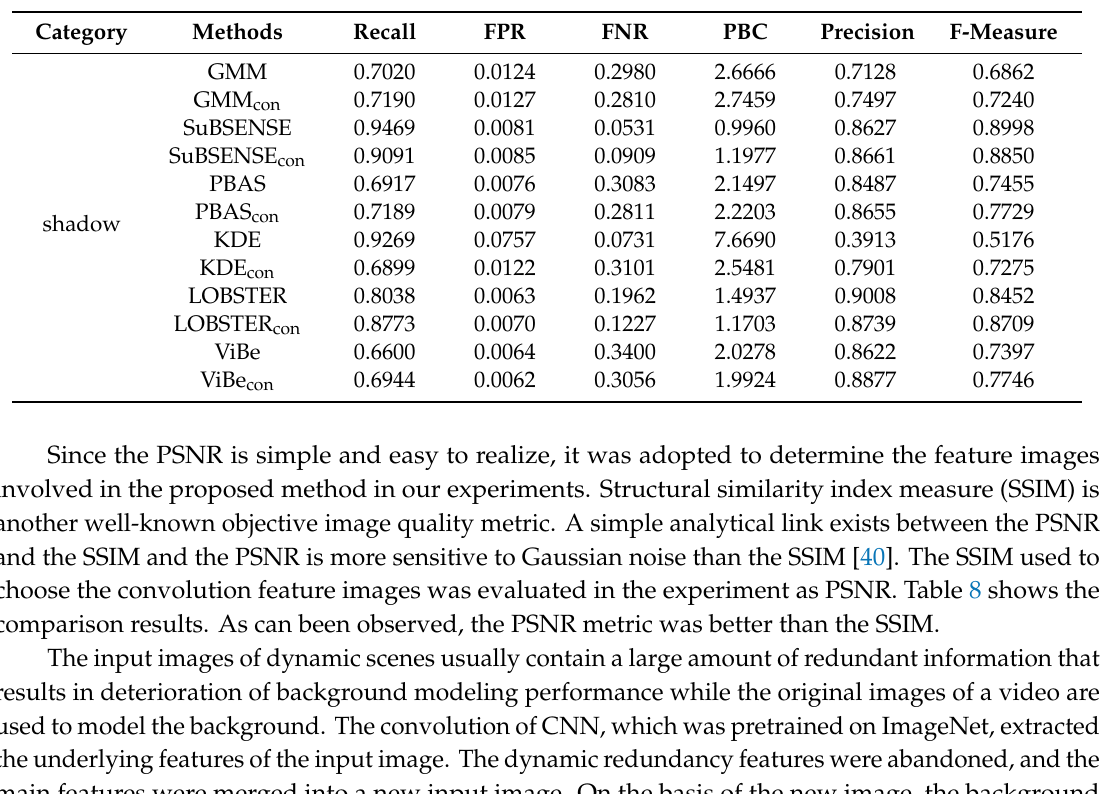
Table 8. Comparisons of PSNR and SSIM for GMM on dynamic scenes.